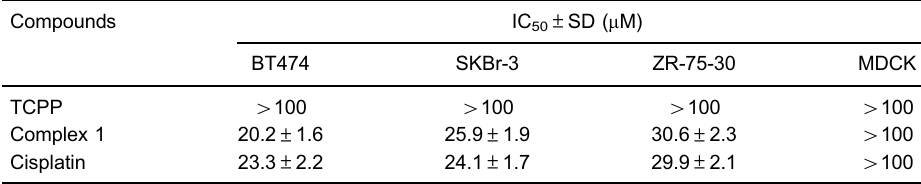
Table 3. Growth inhibitory effects of complex 1 and TCPP on BT474, SKBr-3, ZR-75-30 and MDCK cell lines.